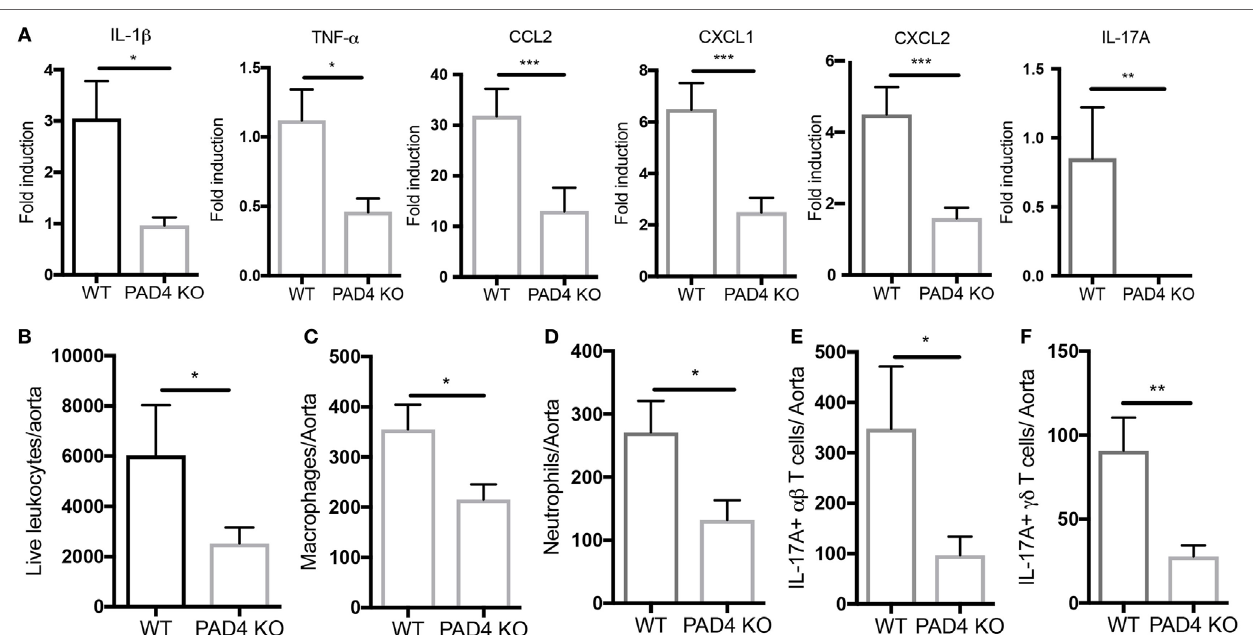
FigUre 4 | Lack of peptidylarginine deiminase 4 (PAD4) in myeloid lineage reduces proinflammatory responses in the aorta. (a) mRNA levels of IL-1 β , TNF- α , CCL2, and IL-17A in the aortas from WT and PAD4 KO mice placed on high-fat chow (HFC) for 10 weeks. mRNA levels were normalized to GAPDH utilizing delta delta CT methods, and expressed relative to levels measured in one of the WT mice Results represent the mean ± SEM ( n = 16–22/group from four independent experiments). Aortas from WT and PAD4 KO mice placed on HFC for 10 weeks were enzymatically digested, and total live aortic leukocytes (B) , macrophages (c) , neutrophils (D) , IL-17A-producing aortic αβ T cells (e) , and IL-17A-producing aortic γδ T cells (F) were quantified by fluorescence-activated cell sorting. Results represent the mean ± SEM ( n = 10–11/group from two independent experiments). * p < 0.05, ** p < 0.01, *** p <